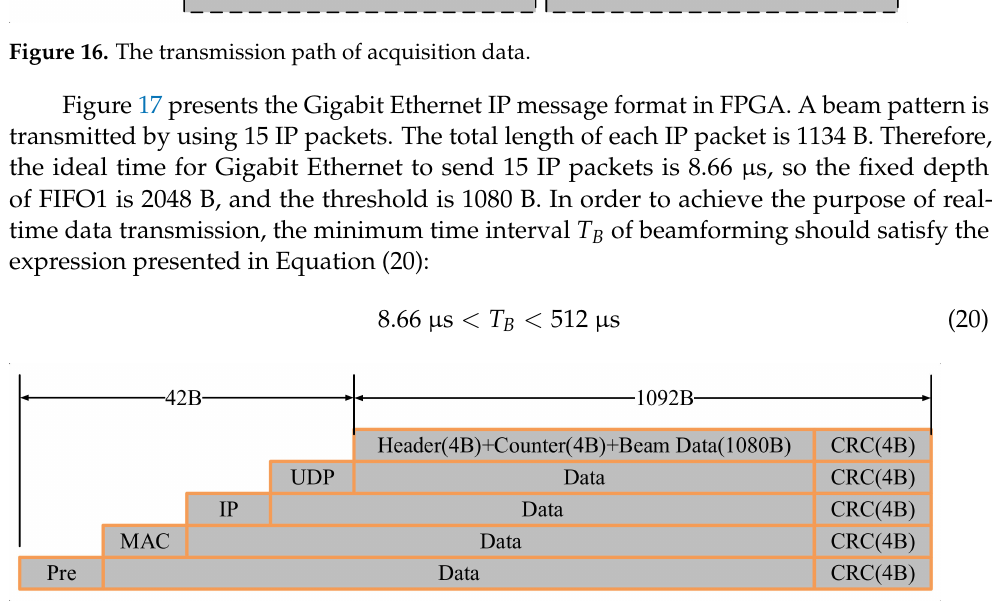
Figure 17. Data frame format of Gigabit